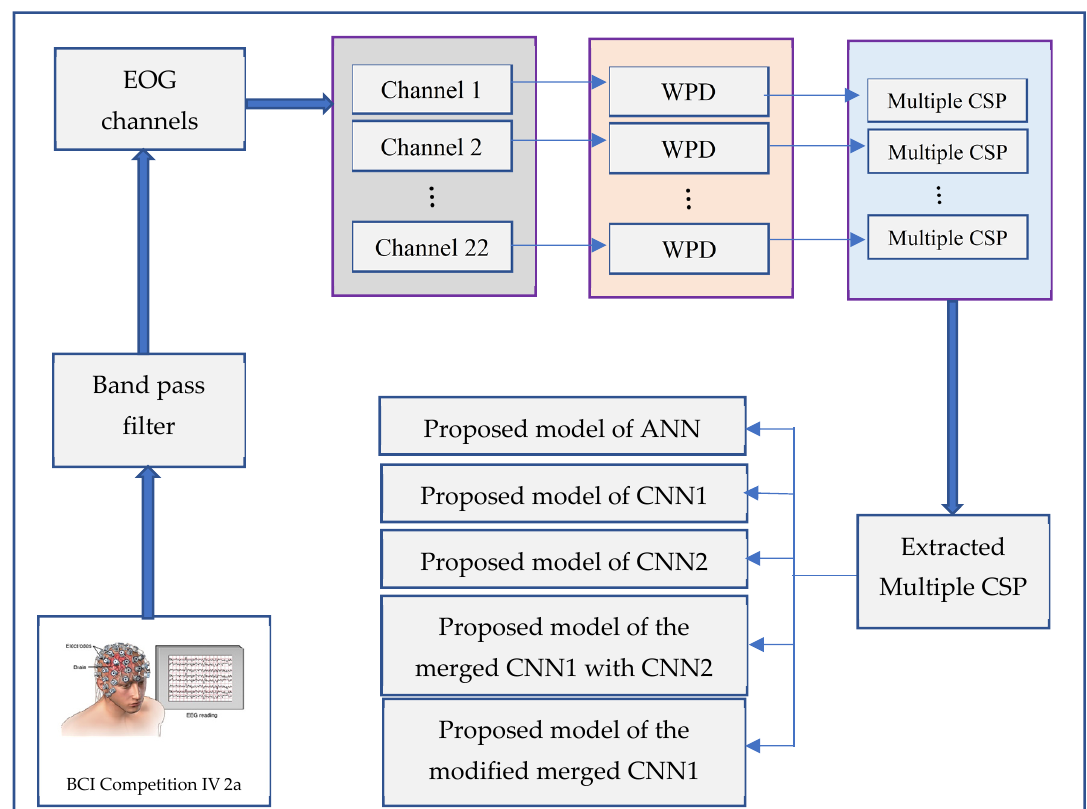
Figure 3. Block diagram of the proposed methodology.